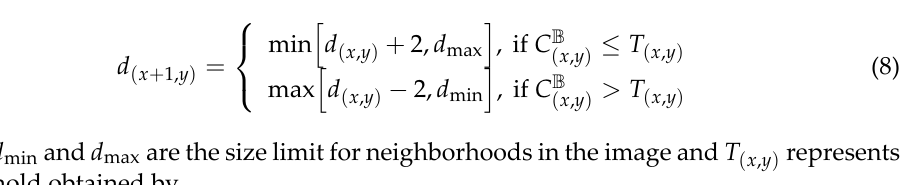
Figure 5. The simulated performance of the scale-adaptive neighborhood. 2.2.3. Adaptive Tuning Factor For the modified Frost filter in this paper, on the one hand, the adaptive tuning factor should change itself as both of the neighborhood property and pixels in the sliding win- dow change. Thus, if the damage of speckle in the sliding window range varies, then the contribution to filter from the pixels there will also be different. On the other hand, the extent to which the central pixel is affected by speckle is significant for the tuning factor. One can measure the representation of the central pixel using t statistics, which can be estimated with the mean and variance in the sliding window. The t statistics for the central pixel are defined as